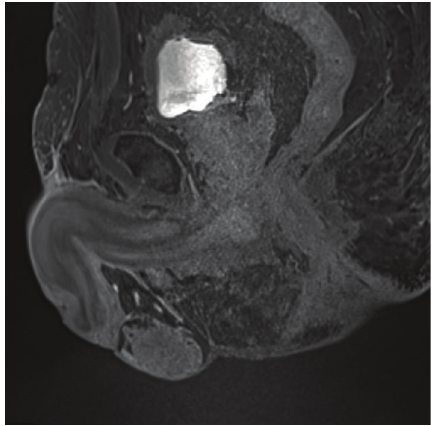
Figure 3: MRI scan which shows a focal lesion on the dorsal side of the glans